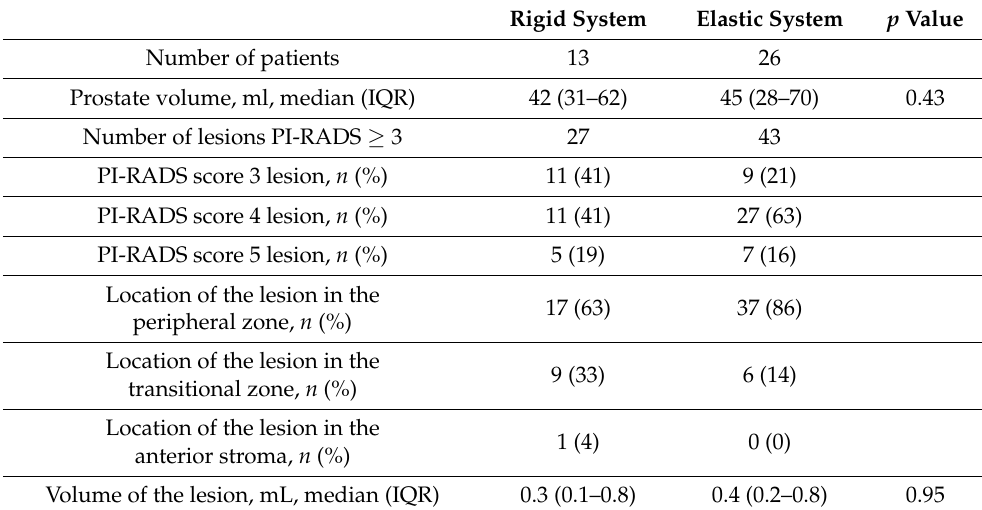
Table 4. Characteristics of patients with significant prostate cancer missed in targeted fusion biopsy. PI-RADS = Prostate Imaging-Reporting and Data